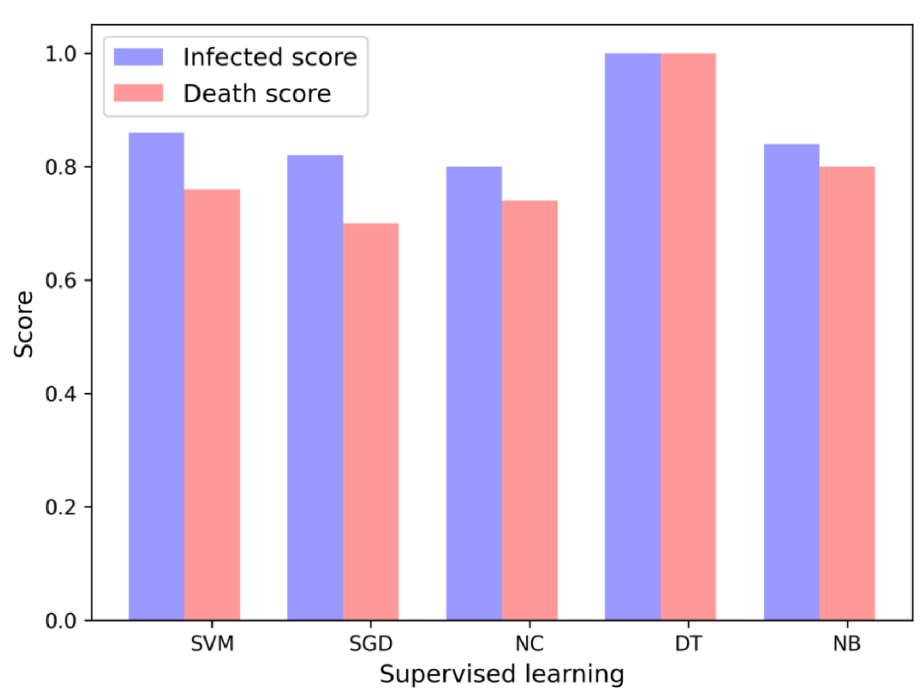
Fig 1. Accuracy scores of the 5-tuple of features for the output variables of infected and death scores for different supervised learning techniques.